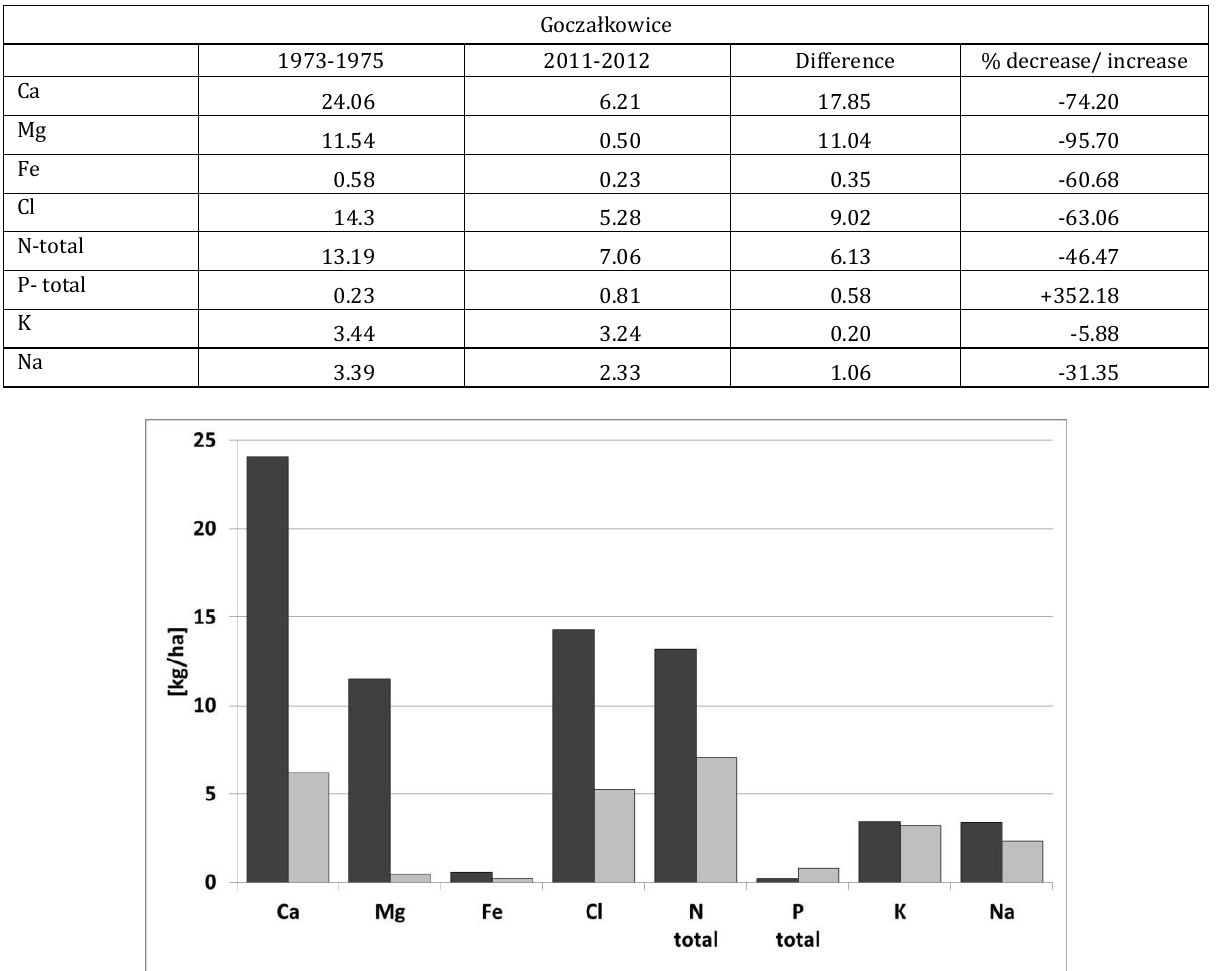
Table 3. Total values for pollutant load in 1973-1975 and 2011-2012 for Goczałkowice [kg·ha -1 ]